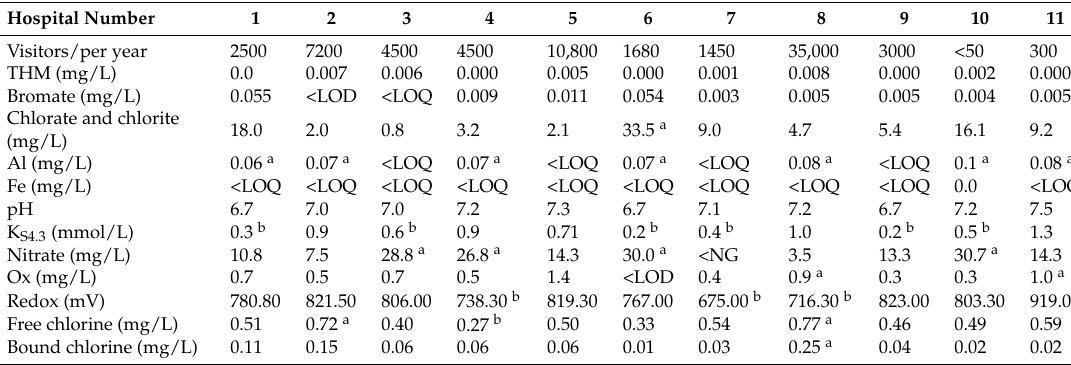
Table 3. Chemistry in pool water samples (according to DIN 19643-1) and number of visitors per year (date from the questionnaire).